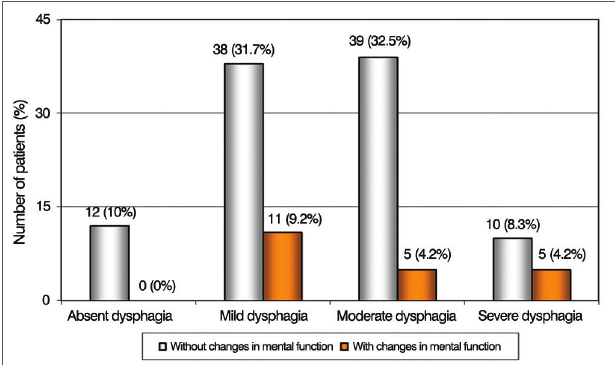
Figure 4. Patient distribution according to the severity of dysphagia and changes in mental function in the Functional Disability Scale by Systems (EIFS).